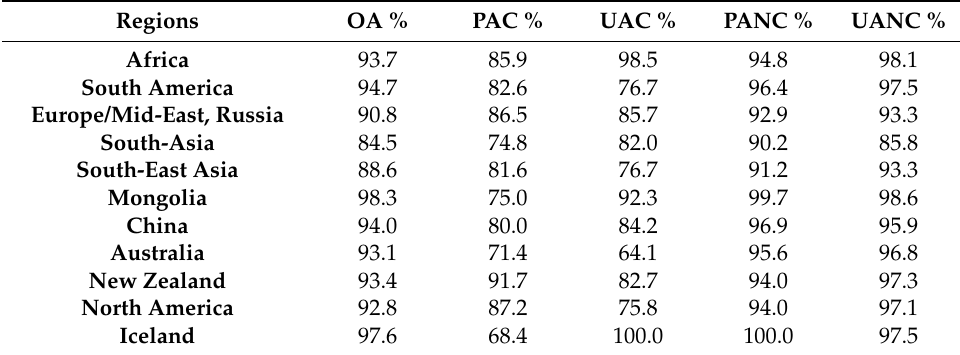
Table 12. The accuracy measures of GFSAD30m GFSAD cropland extent map. Regions